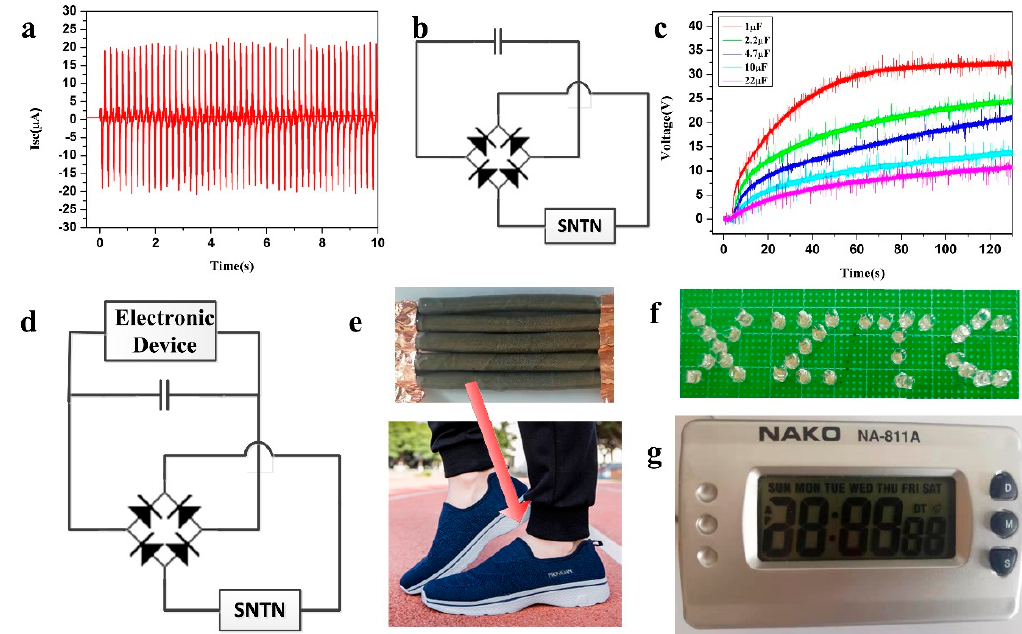
Figure 5. The SNTN as an energy source. ( a ) Short-circuit current of five SNTNs connected in parallel; ( b ) The working circuit of the charging system; ( c ) Charging curves of 1, 2.2, 4.7, 10, and 22 µ F capacitors charged by the five SNTNs connected in parallel; ( d ) The working circuit for electronic devices; ( e ) Five SNTNs connected in parallel and fixed under the foot; ( f ) 31 LEDs and ( g ) digital clock applications of the